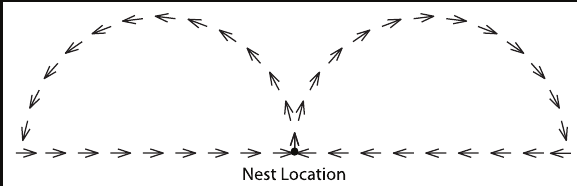
Figure 12. Artificial learning walks. The artificial learning walks are structured so that the outbound sections of the paths are curved while the returns are straight. Behavioural modulation of learning is achieved as views are only consistent during the straight inbound sections.